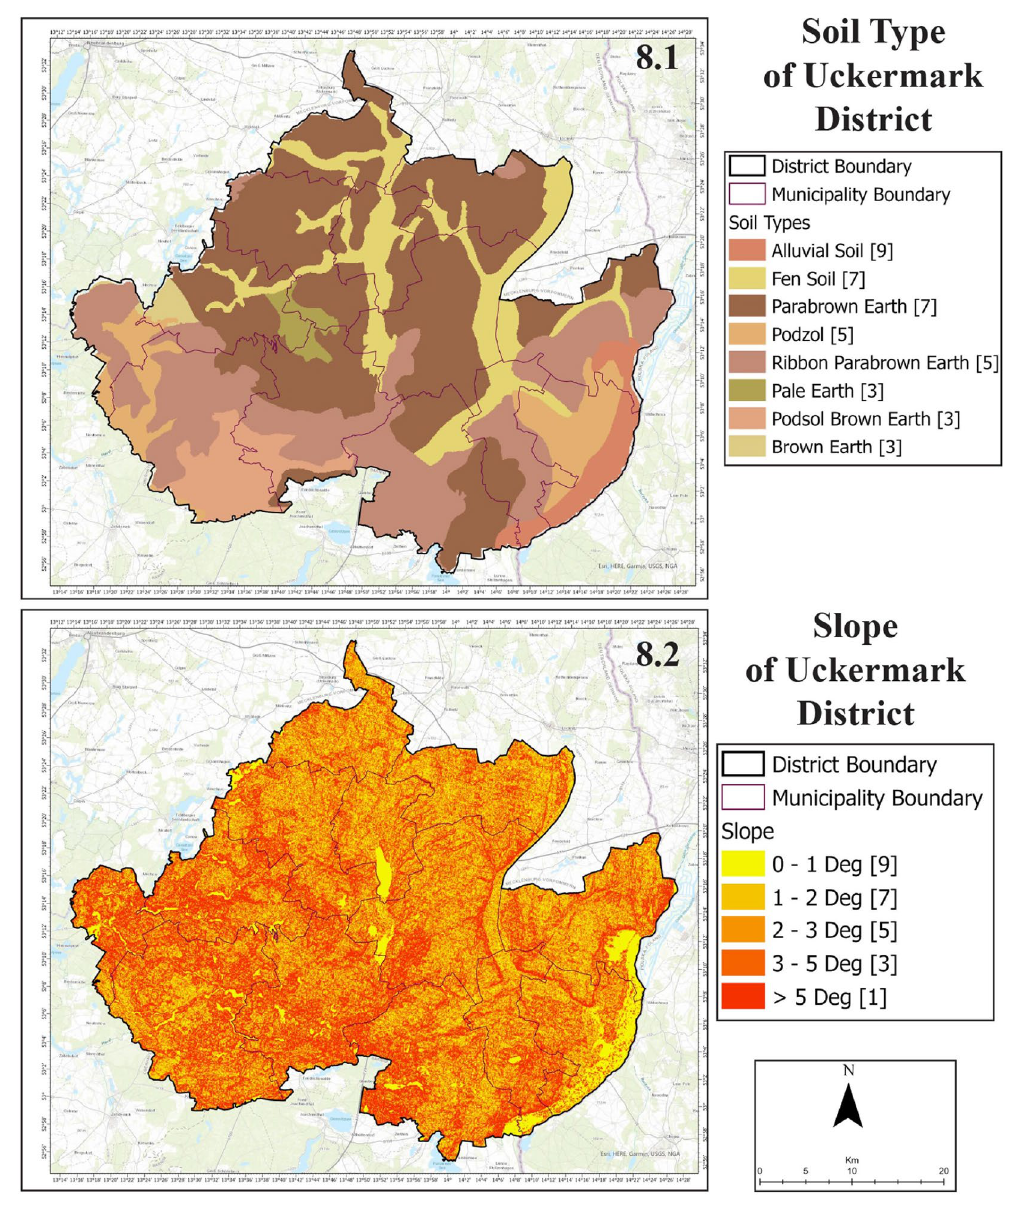
Figure 8. Soil type (8.1) and slope (8.2) of Uckermark